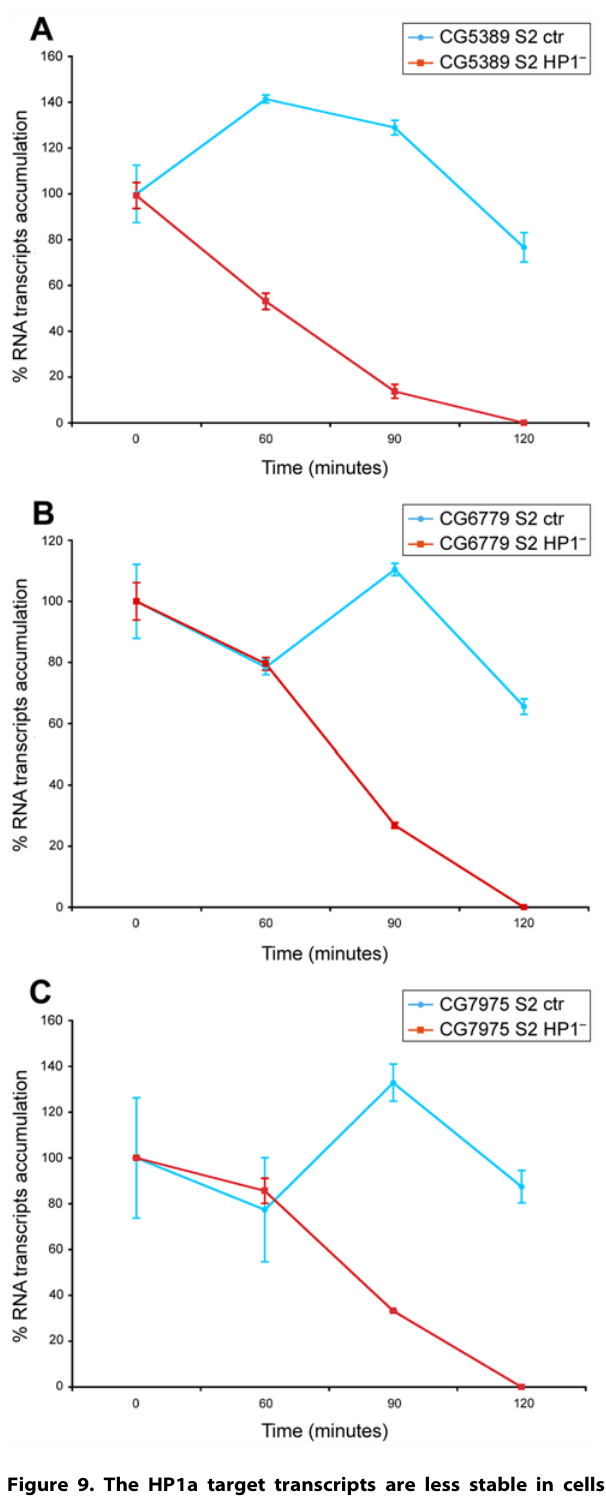
Figure 9. The HP1a target transcripts are less stable in cells lacking HP1a. Quantitative RT–PCR analysis of three HP1a target transcripts at different times after blockage of transcription by actinomicyn D treatment. The blue lines and the red lines respectively indicate the transcripts amount in S2 control cells and S2 cells interfered with HP1a dsRNA. Target transcripts correspond to genes: (A) CG5389, (B) CG6779, (C) CG7975. Note that at 120 minutes, the HP1a target transcripts are not detectable in HP1a depleted cells while in control cells their amount is only slightly decreased.